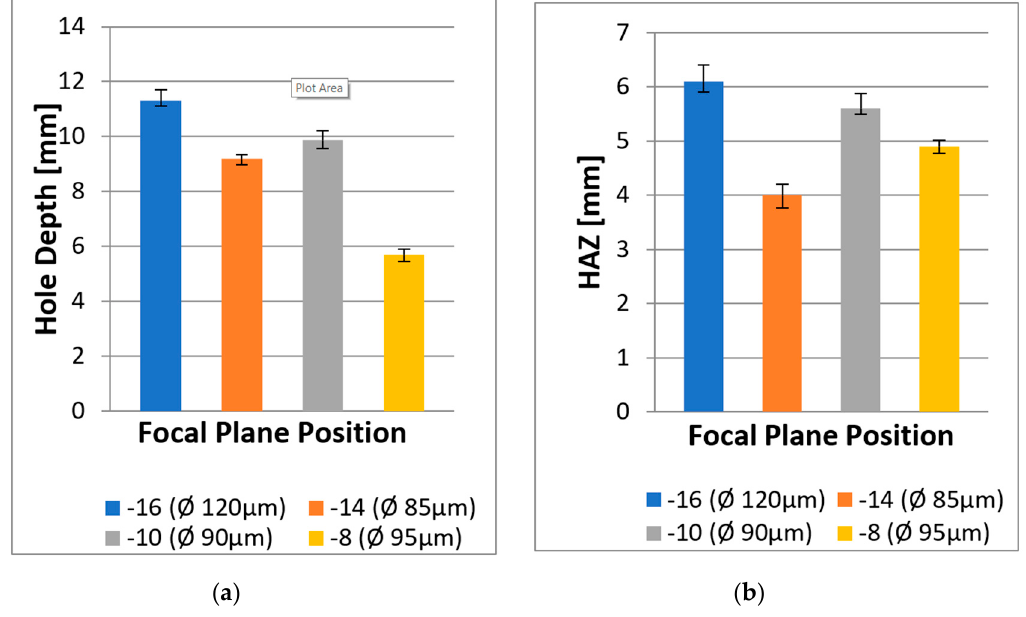
Figure 12. The results of two drilling strategies: ( a ) single ring shape with 10 multiple passes and ( b ) spiral trepanning with single